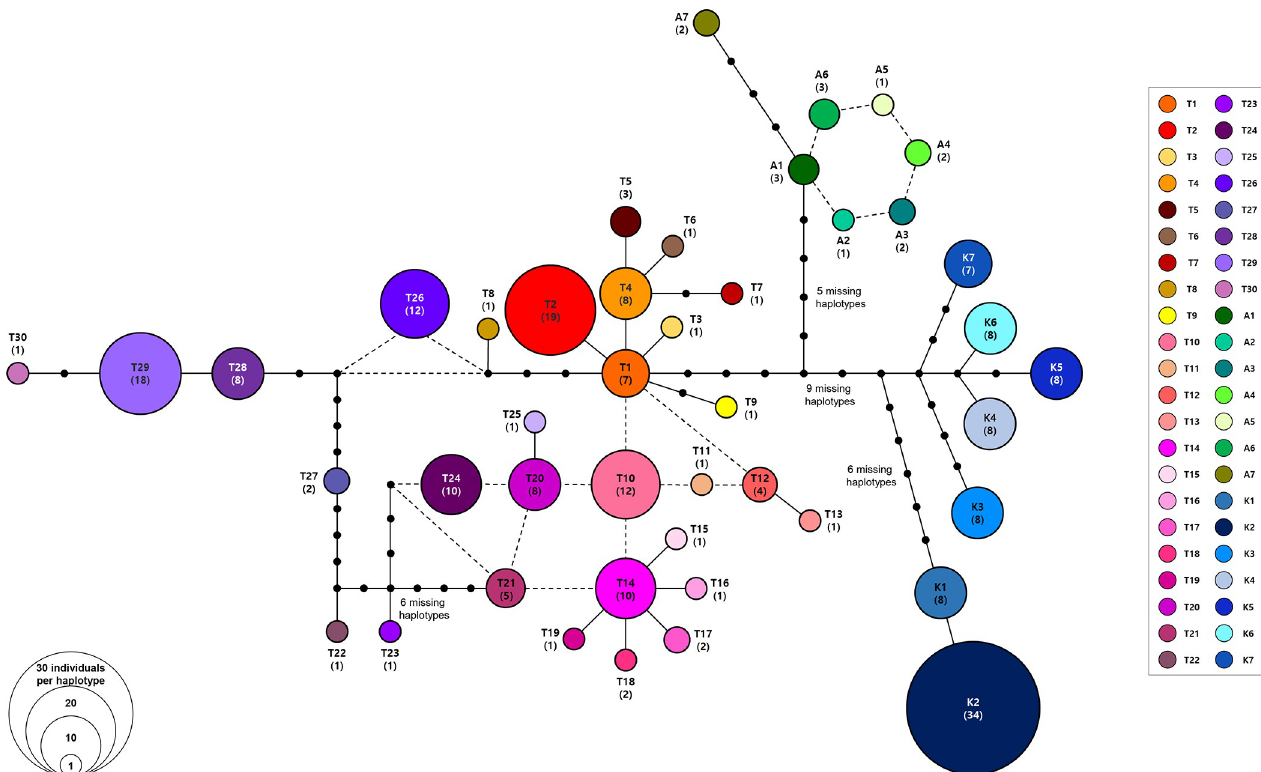
Fig 5. TCS haplotype network. Relationships among the 44 haplotypes found in Phedimus takesimensis on Ulleung Island and the two continental progenitor species, P . kamtschaticus and P . aizoon . Small dots represent either missing or inferred haplotypes and the size of each circle is proportional to the population size.